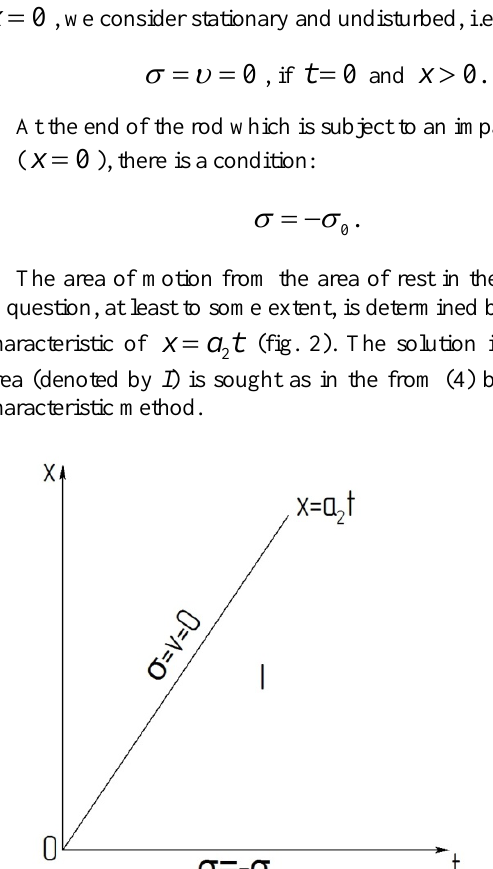
Fig. 1. The settlement scheme.